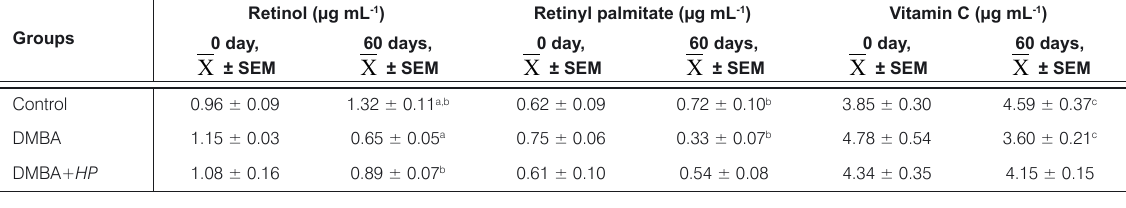
Table 5. Retinol, retinyl palmitate and vitamin C levels at different periods in control, DMBA and DMBA+ HP groups in serum rat